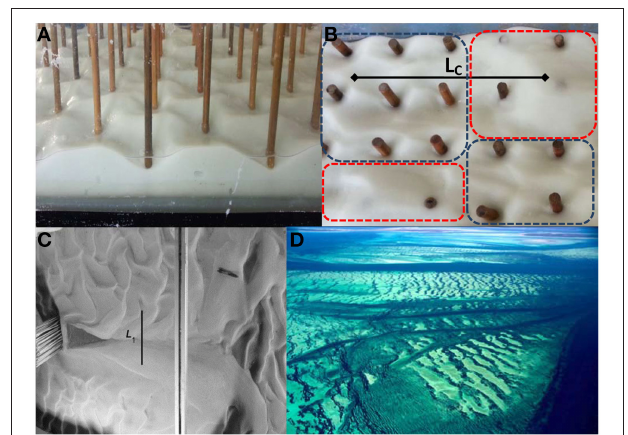
FIGURE 2 | Demonstrations of scales of sediment transport in seagrass meadows. (A) Stem-scale scour in the laboratory (Ng, 2013); (B) Canopy-scale heterogeneity of sediment transport in a uniform array in the laboratory (adapted from Ng, 2013). Alternating zones of strong sediment deposition (red zones, often burying canopy elements) and sediment erosion (blue zones), separated by a distance of the order of L C , are evident; (C) Panoramic view of patch-scale sediment transport in the laboratory. The patch on the left-hand side (flow is from left to right) creates strong scour within the patch, deposition behind the patch, and patch-driven bedforms (taken from Follett and Nepf, 2012); (D) Fauré Sill (500 km 2 ) in Shark Bay, Western Australia, which has formed through thousands of years of sediment deposition within a seagrass meadow (Davies, 1970; image taken by Western Australian Department of Parks and Wildlife